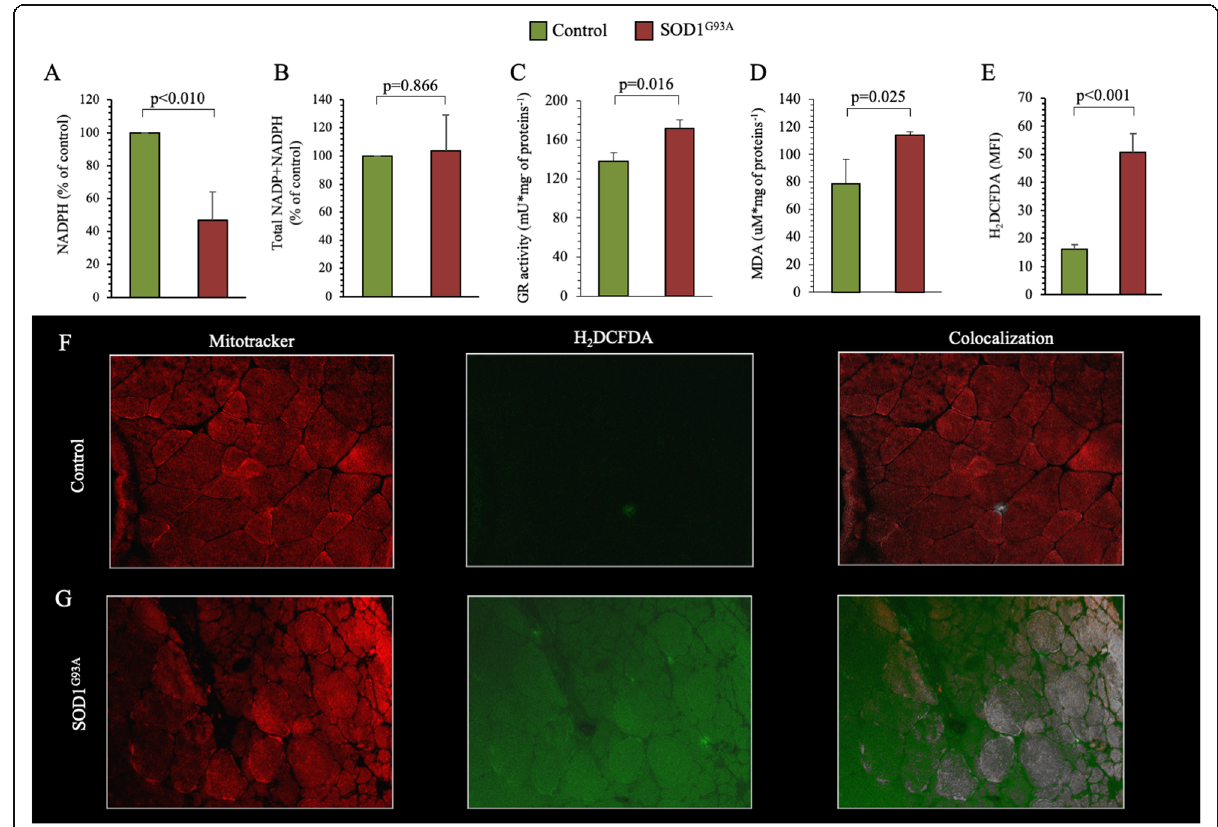
Fig. 4 Antioxidant response and oxidative stress in SOD1 G93A mutation. a , b NADPH levels and total NADP+NADPH content in control (green column) and SOD1 G93A (red column) quadricep homogenates represented as percent of control. c GR activity and d MDA content in control (green column) and SOD1 G93A (red column) quadriceps. e Mean fluorescence index (MFI) of H 2 DCFDA in control and SOD1 G93A quadriceps muscles. f Immunofluorescence representative images of MitoTracker® (as specific mitochondria staining — red fluorescence), H 2 DCFDA (as specific ROS staining — green fluorescence), and colocalization staining signals, in control and SOD1 G93A quadriceps. Data are expressed as mean ± SD, n = 3 for each group. Student t test for unpaired data was used for statistical